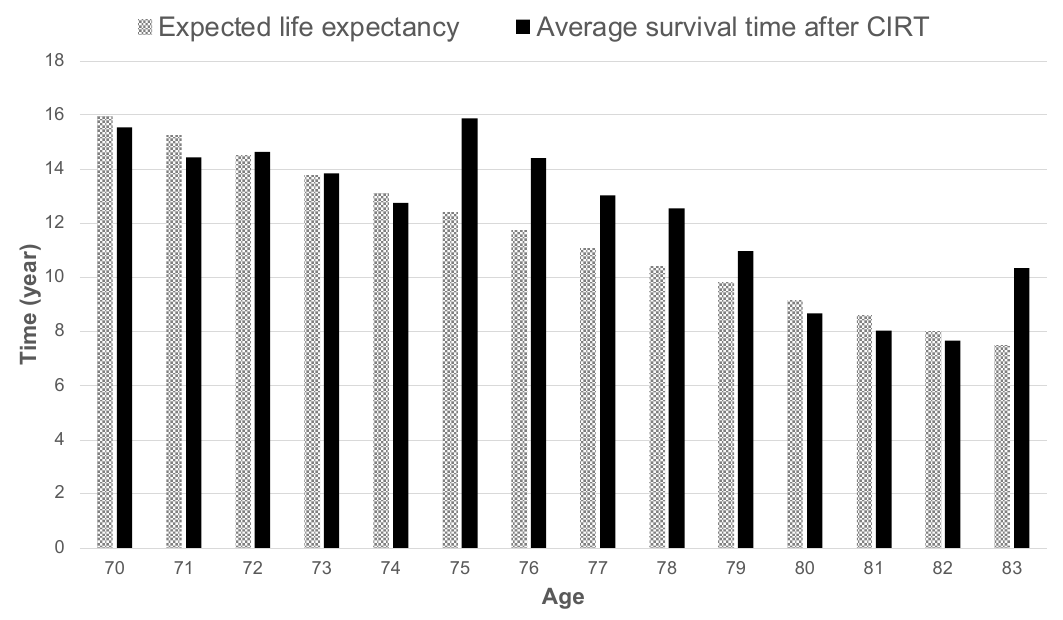
Figure 3. Expected life expectancy by age in Japan in 2020 compared to the average overall survival time by age at the start of carbon-ion radiotherapy .